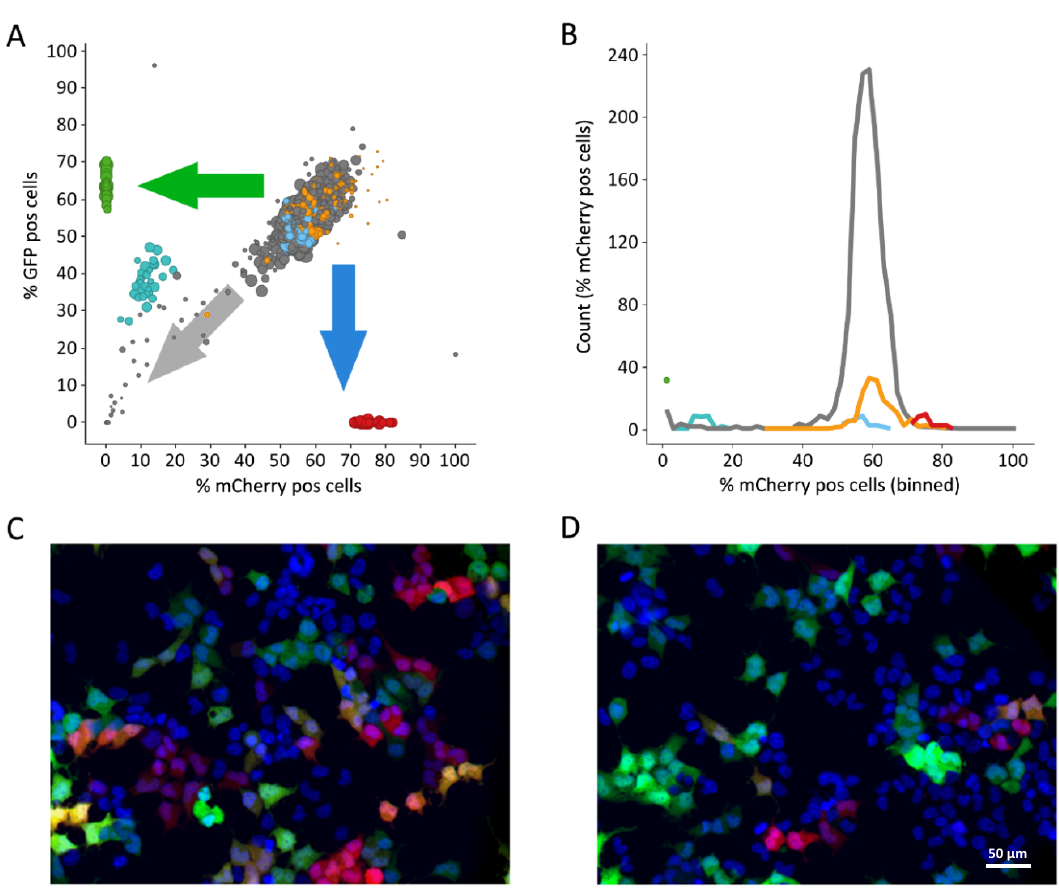
Figure 1. Fluorescence-based proof-of-concept screen. ( A ) The plot illustrates the proportion of red and green cells within all wells. Green data points reflect control wells transduced with the eGFP-expressing vector only (azidothymidine (AZT)-resistant mutant); red data points, with the mCherry-expressing vector only (wild-type strain). These two controls demonstrate the location of the data points, if a compound would completely inhibit just the mutant or the wild-type strain, respectively. The turquoise data points correspond to the co-transduced, AZT-treated wells and clearly demonstrate that the wild-type strain (mCherry) is more strongly inhibited by AZT than the AZT-resistant mutant (eGFP). Co-transduced, DMSO-treated wells served as negative controls and are shown in orange, co-transduced untreated wells in light blue. Co-transduced wells treated with the compounds to be analyzed are depicted in grey. Compounds inhibiting both strains are located in the direction of the grey arrow, with the most effective compounds being close to the origin of the plot, at 0% eGFP and 0% mCherry. Compounds inhibiting the wild-type strain only would be located in the direction of the green arrow, whereas compounds inhibiting the AZT-resistant mutant only would be located in the direction of the blue arrow. An intermediate inhibition characteristic is given with the AZT control (turquoise data points), mostly but not exclusively inhibiting the wild-type strain. Cell viability is illustrated by the size of the data points. ( B ) Frequency distribution of the fluorescence-based screening using the same color coding as in A. ( C ) Fluorescence microscopic image of co-transduced HEK293T-cells within a DMSO-treated control well. EGFP-positive cells (AZT-resistant mutant) are depicted in green, mCherry-positive cells (wild-type strain) in red, nuclei are stained in blue. Double-positive cells show a color gradient from orange to yellow based on expression levels. Scale bar as in D. ( D ) Fluorescence microscopic image of co-transduced HEK293T-cells within an AZT-treated well, less mCherry-positive cells are visible. Color coding as in C. The screening was performed using the LOPAC library of 1280 drug-like compounds, each at a concentration of 1 µM. The average z' of the four 384-well plates was 0.62, and the standard deviation of the transduction rates for the high controls was 7% on average, confirming the robustness of the assay system. Although most compounds did not affect the transduction efficiencies as evident from